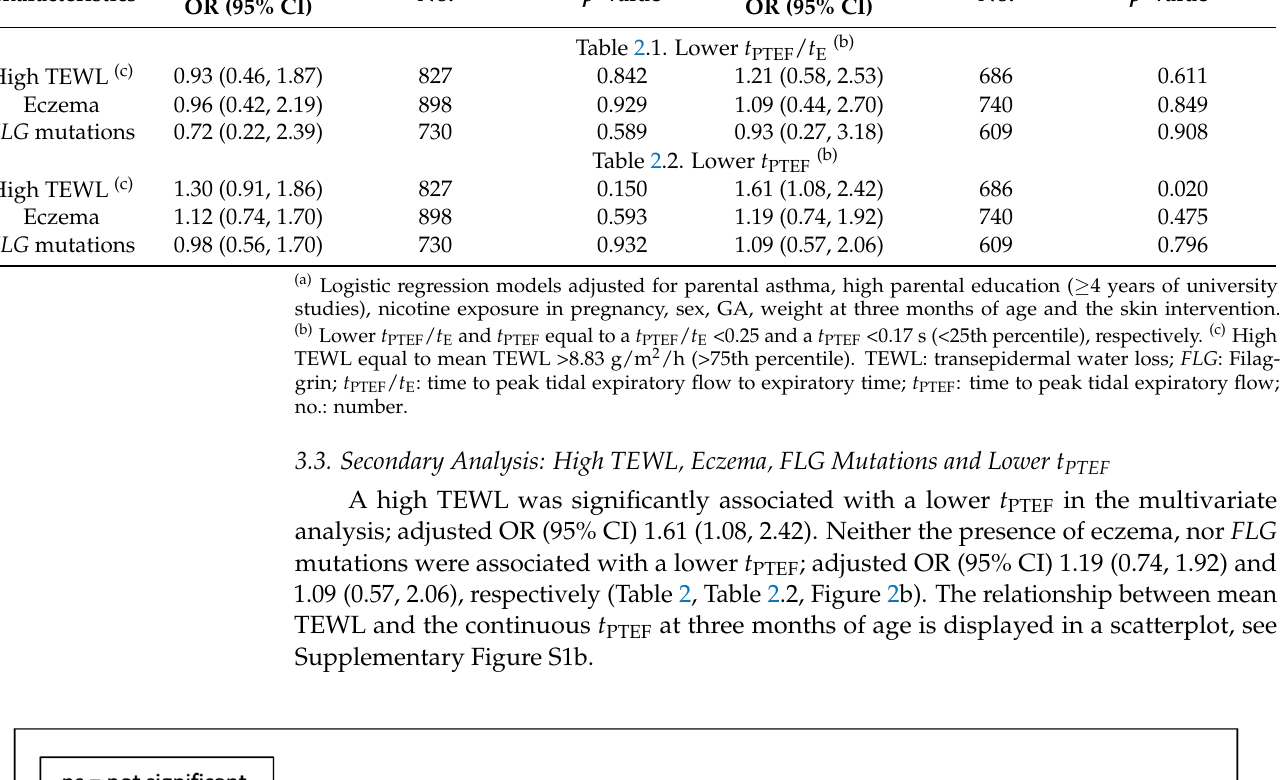
Table 2.1. Lower t PTEF / t E (b)